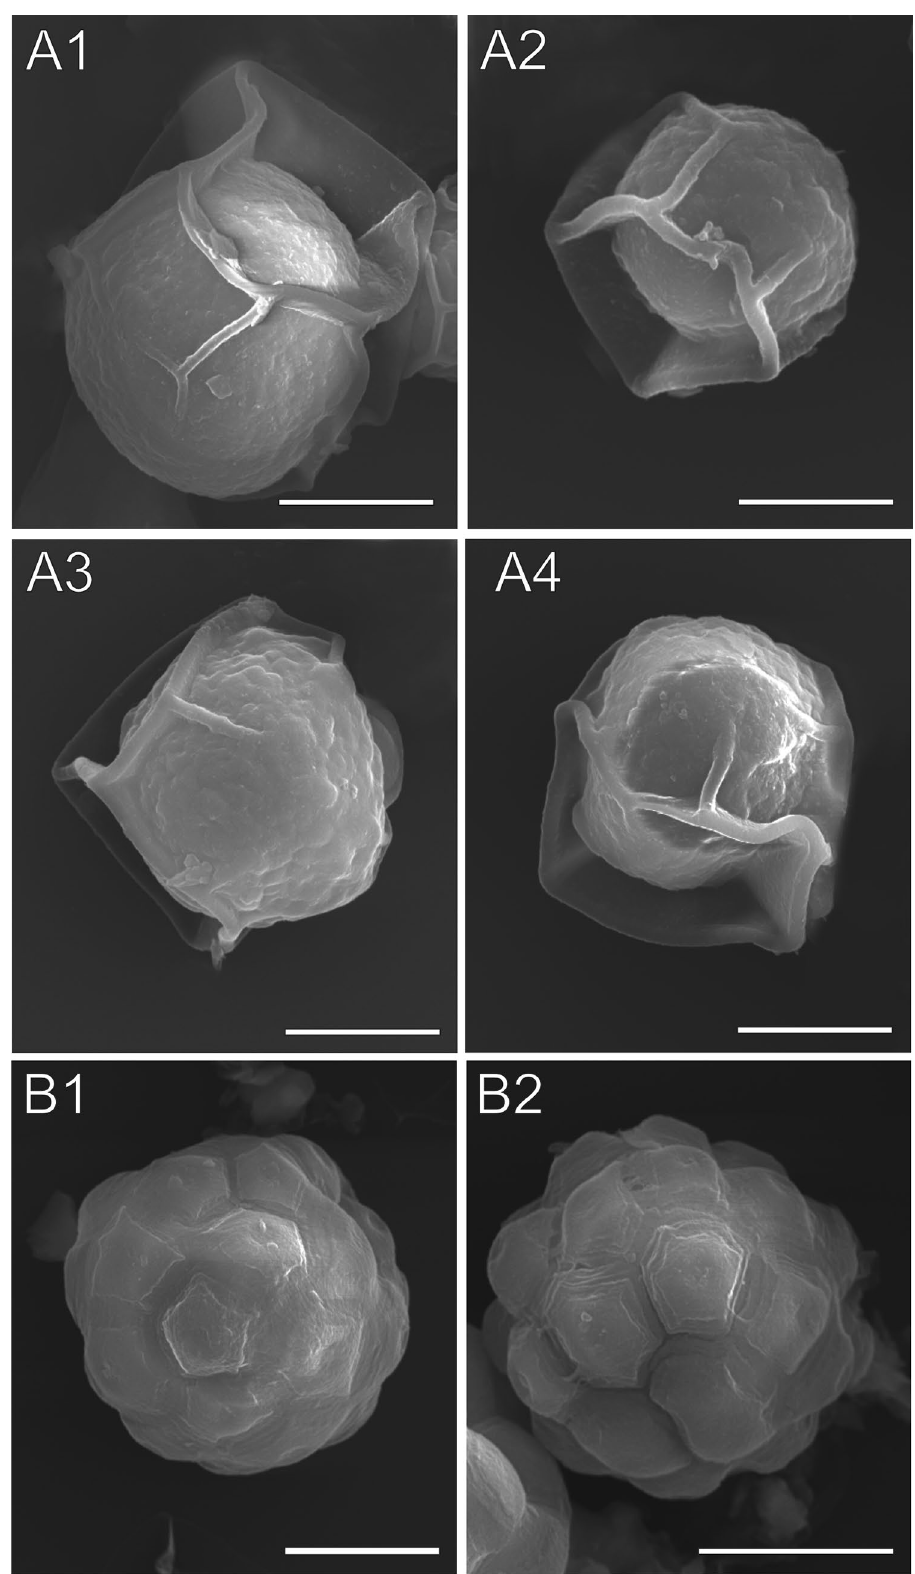
Figure 3. SEM images of fixed S. nivaloides from Longyearbreen Glacier: A1-A4—cysts, B1, B2—hypnozygotes. The scale bar corresponds to 10